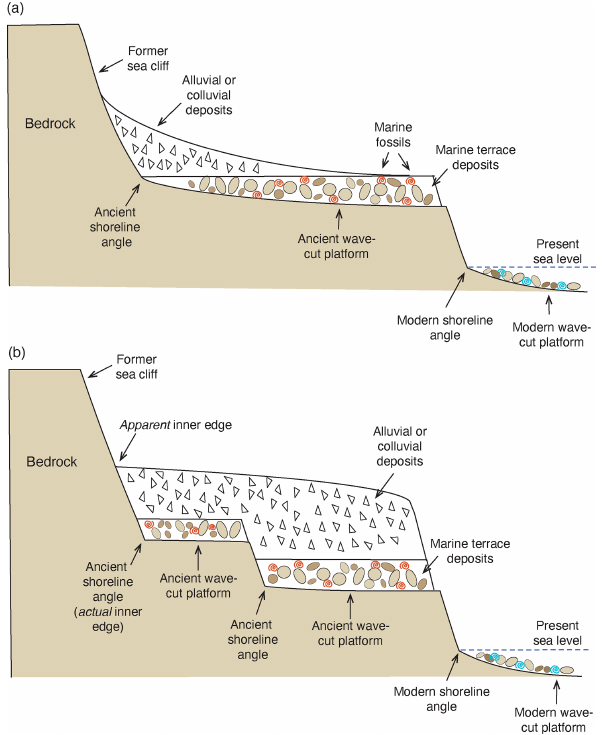
Figure 3. Diagrams showing the terminology used for marine ter- races: (a) simple case of a modern wave-cut bench or platform in the surf zone with marine gravels and modern shells (blue symbols), shoreline angle, and single emergent marine terrace above it, with a colluvial cover masking most of the marine terrace deposits with their fossils (red symbols). Such an emergent terrace could have formed from a higher-than-present sea level or from uplift since the time of initial terrace formation; (b) more complex case on an uplifting coast with the features described above but an additional (older) terrace above the lower one. Note that in (b) , colluvial de- posits cover both of the emergent terraces, making them appear as one landform, with a single inner edge that is at a higher elevation than the shoreline angles of both emergent terraces.